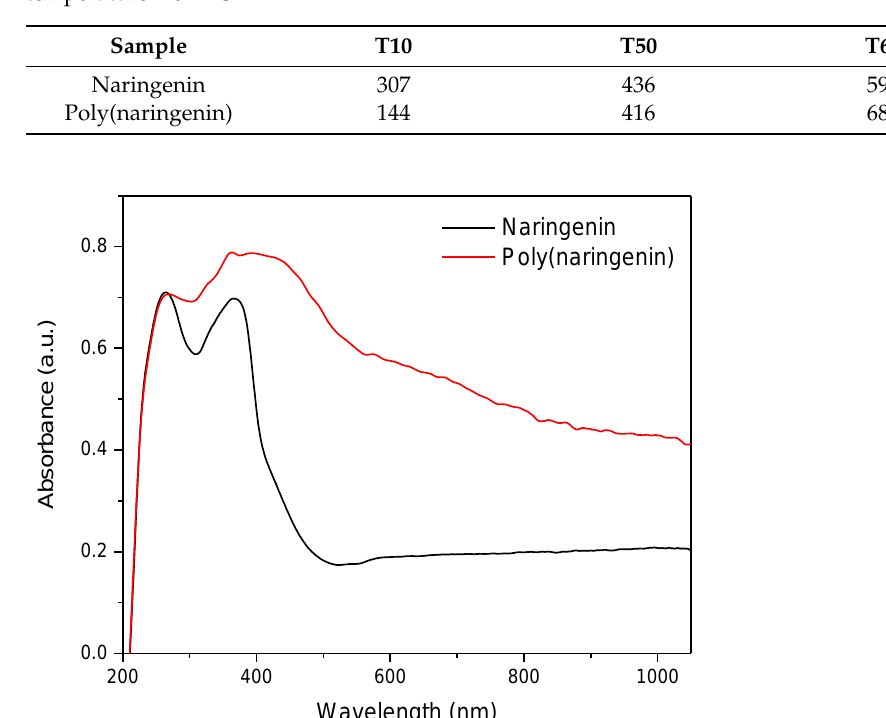
Figure 5. FTIR spectra of naringenin and poly(naringenin).